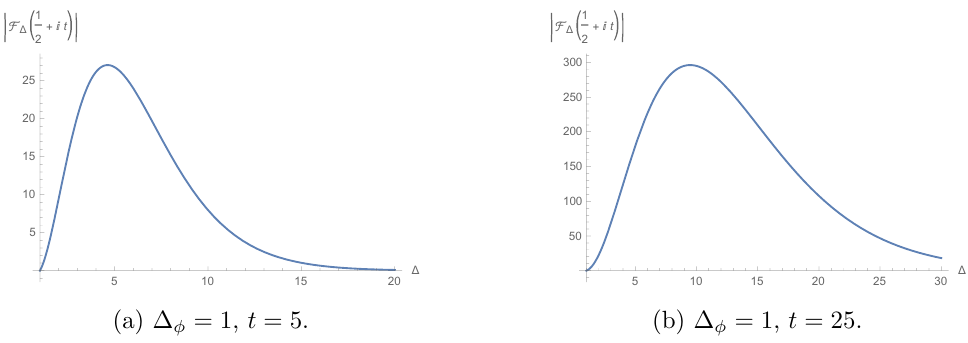
Figure 3. Plots of F (cid:1) (1 = 2 + it ) vs (cid:1) for (cid:1) (cid:30) = 1 and two values of t . One can see that the plot is peaked for a value of (cid:1) that increases roughly with